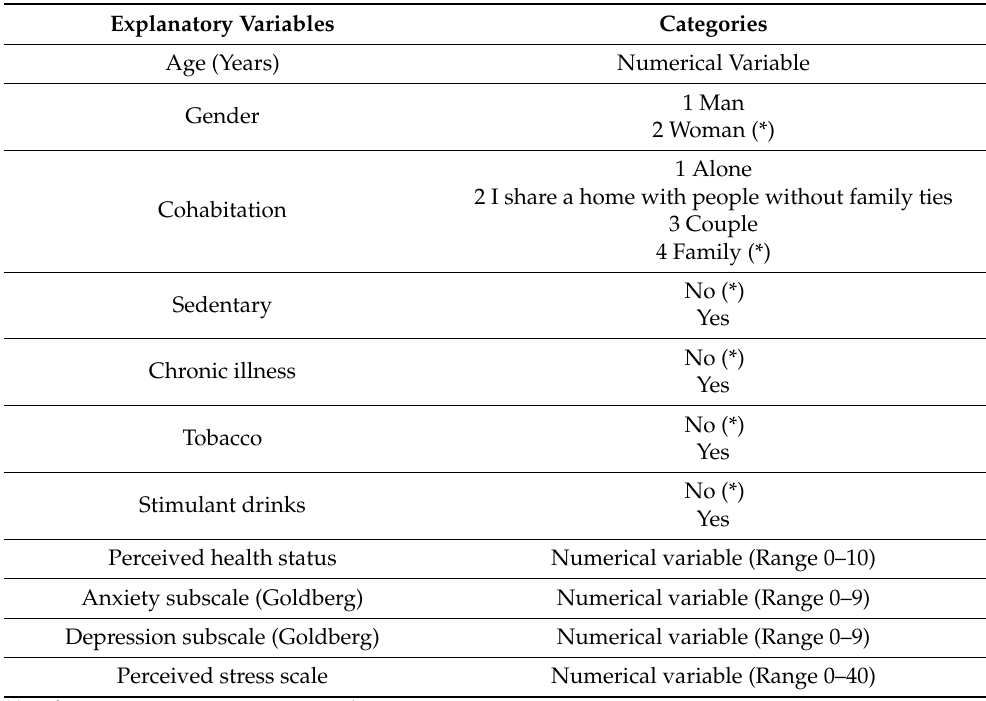
Table 7. Explanatory variables included in the initial model.